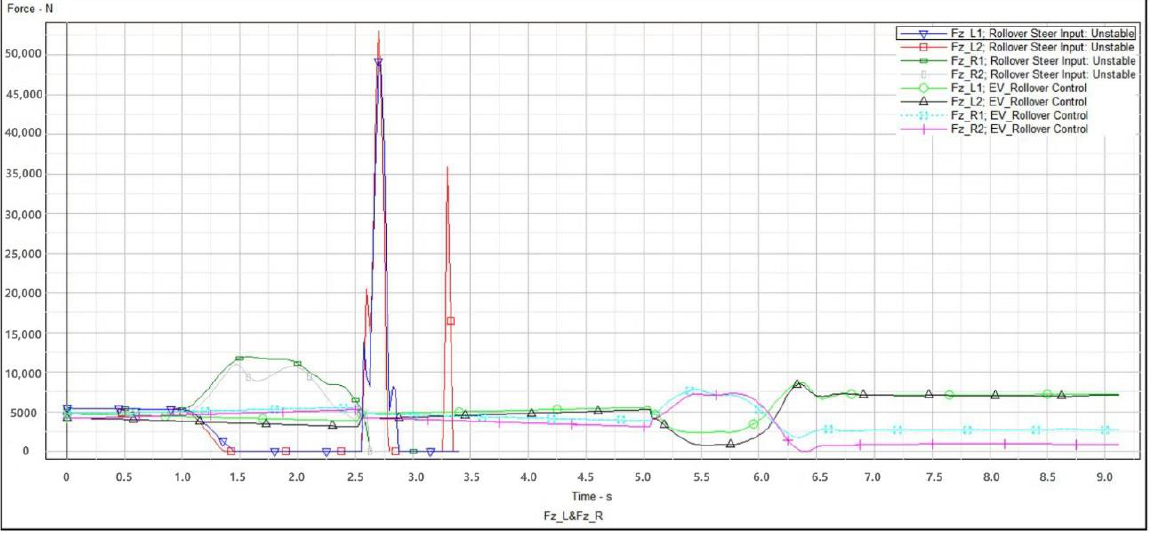
Figure 9. Wheel vertical load comparison curve for fishhook test.